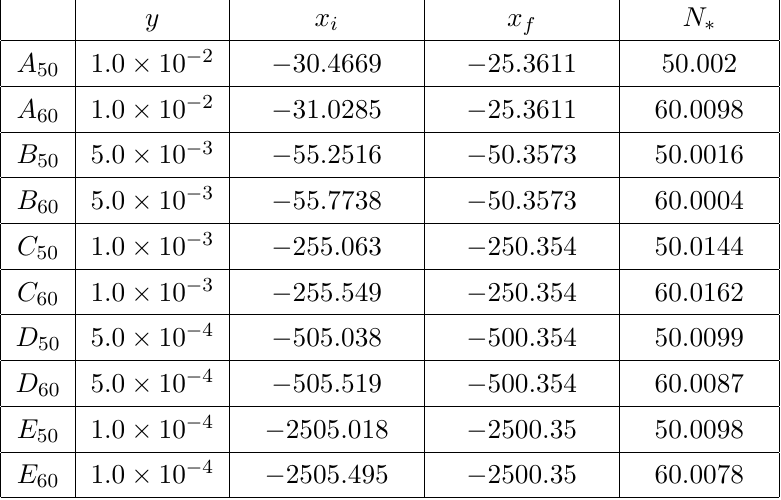
Table 1 . Sample of our numerical solutions x i , x f , N ∗ at some points of y .